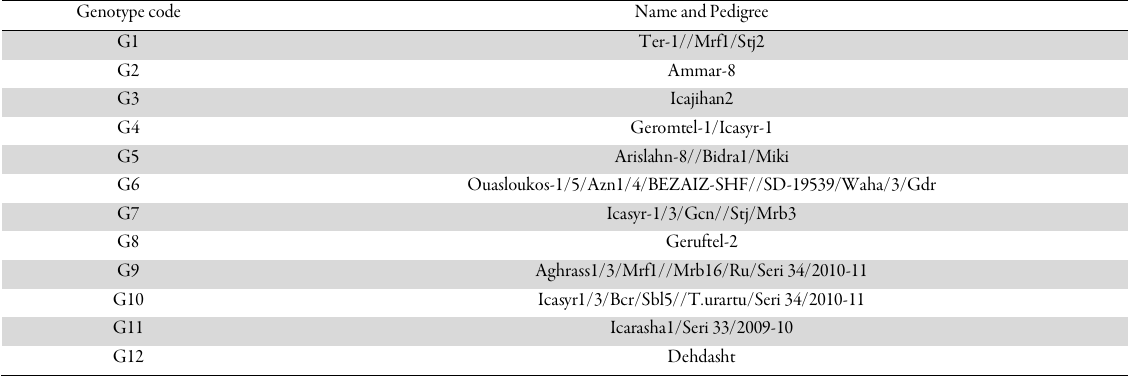
Table 1. Name and pedigree of durum wheat genotypes Genotype code